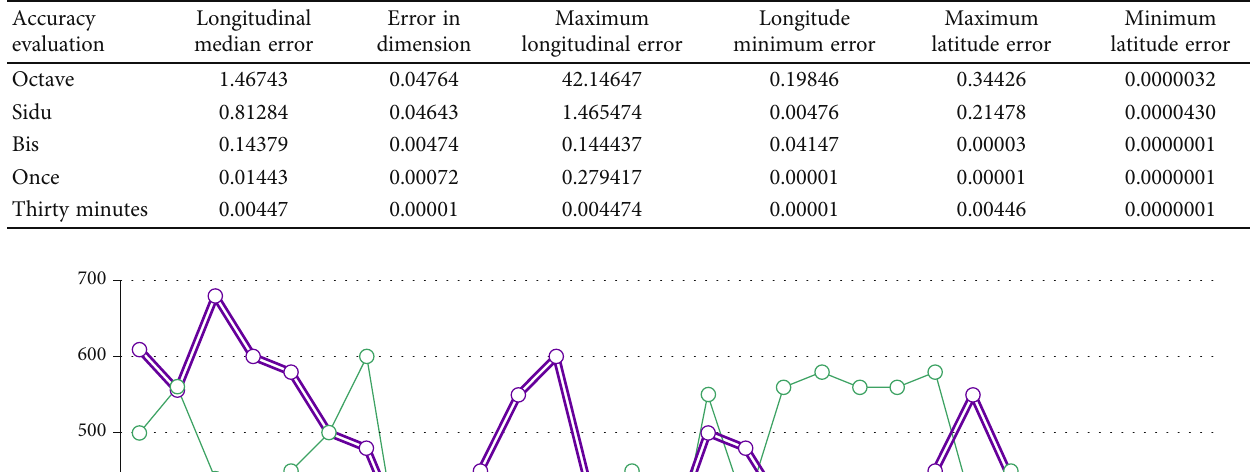
Table 2: Error statistics.